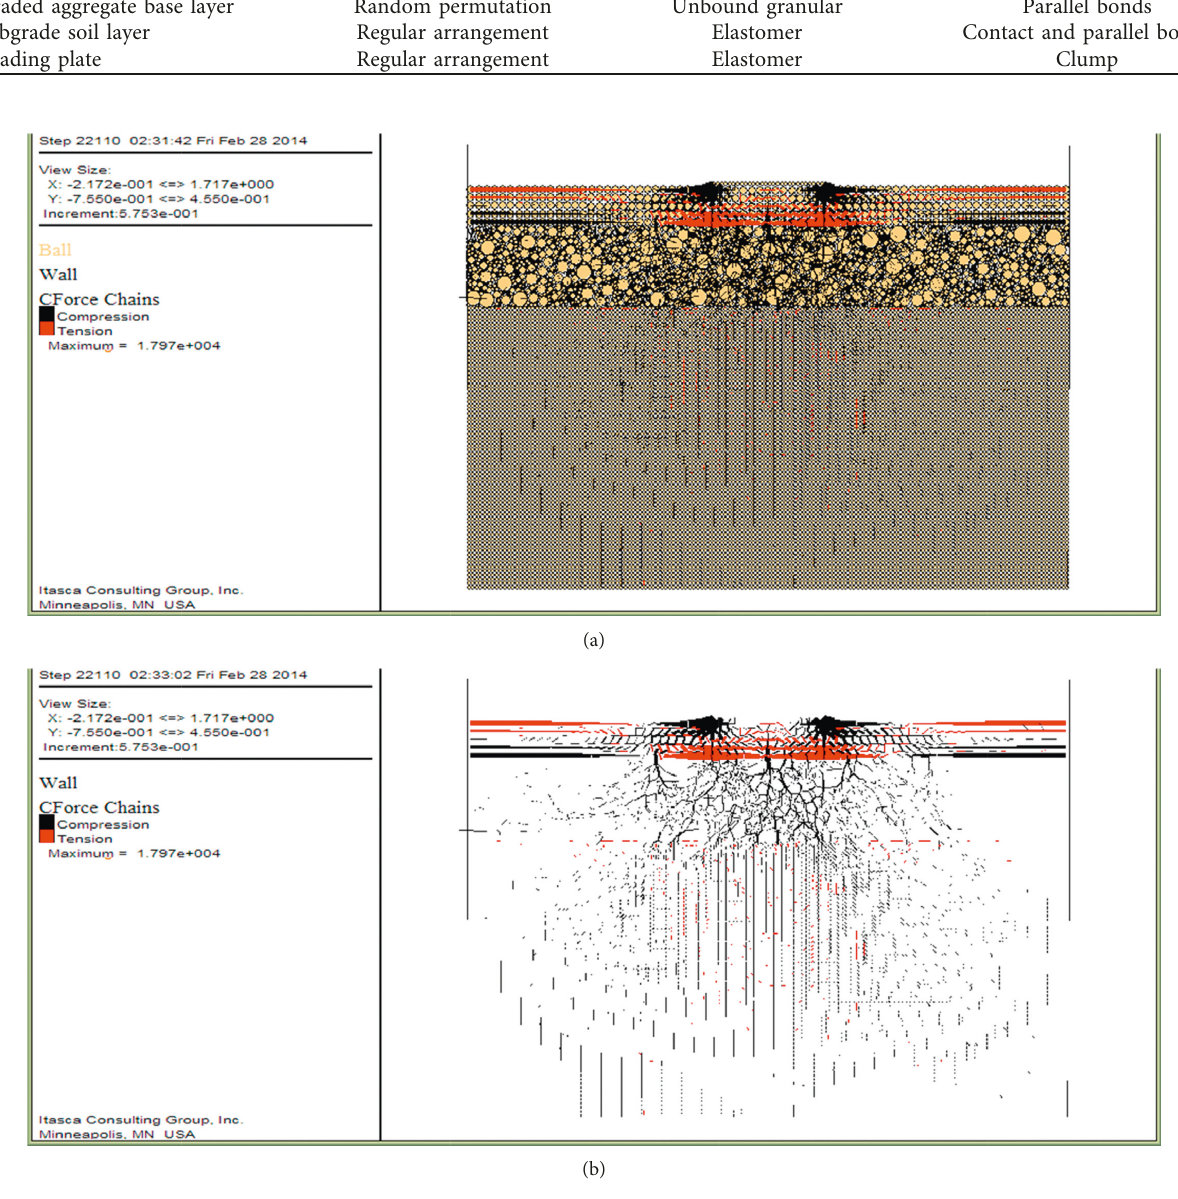
Figure 3: Stress distribution of the model (black and red denote pressure and tension,